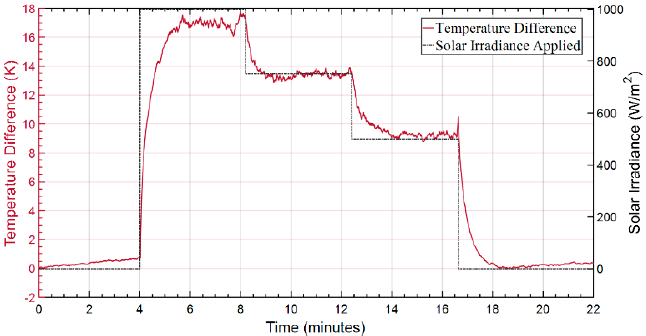
Figure 5. Temperature behavior obtained with the white fiber ( blue trace ), and with the black fiber ( black trace ), under ~4-min solar irradiance cycles of 0 W / m 2 , 1000 W / m 2 , 750 W / m 2 500 W / m 2 , and 0 W / m 2 , at room temperature.